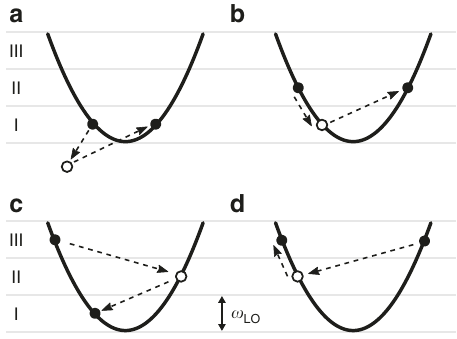
Fig. 6 Schematics of two-phonon processes. Schematics of selected 2ph processes in energy region I ( a ), region II ( b ), and region III ( c , d